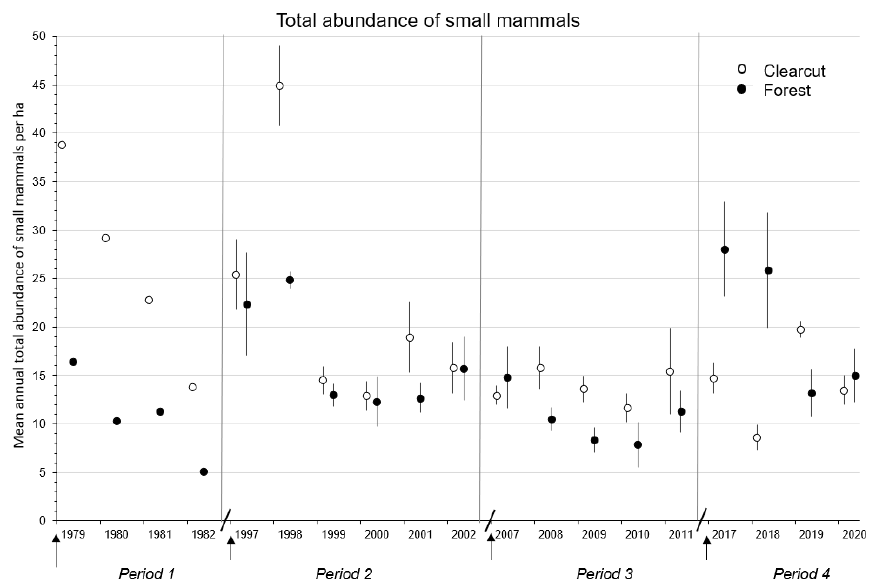
Figure 1. Mean ( n = 1, 3, or 4 replicate sites) ± SE total annual abundance of forest-floor small mammals in the first four to six complete years in clearcut and uncut forest sites during the Periods 1979–1982, 1997–2002, 2007–2011, and 2017–2020 for the CC-FOR study in southern British Columbia, Canada. Arrow indicates time of harvesting on clearcut sites. Diagonal line separates Periods . Mean annual species richness of the small mammal communities was significantly ( F 3,7 = 16.35; p < 0.01) different across Periods 1 to 4 of cumulative forest harvesting with the number of species being highest (DMRT; p = 0.05) overall in Period 2, followed by Periods 3 and then 4 (Table 2 and Figure 2). In terms of overall mean species richness, Periods 1 (2.72) and 4 (2.63) were similar. Again, there were significant ( p ≤ 0.03) effects of time and treatment × time interaction across the three Periods , whereby richness generally declined with post-harvest year (Table 2).